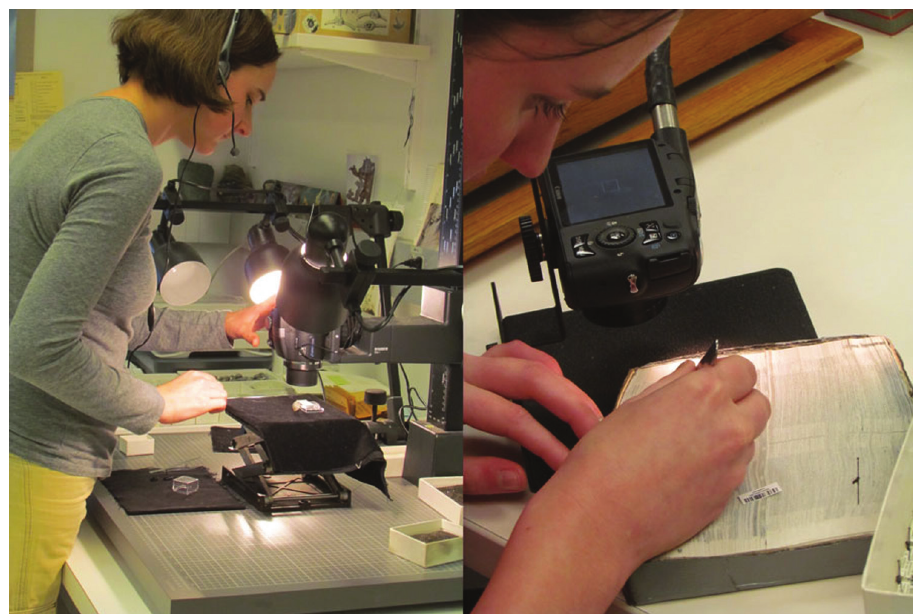
Figure 2. Specimen image capture. Fossil specimen imaging, specimen label imaging. Two very different imaging set-ups. Yale Peabody Museum, University of Kansas -